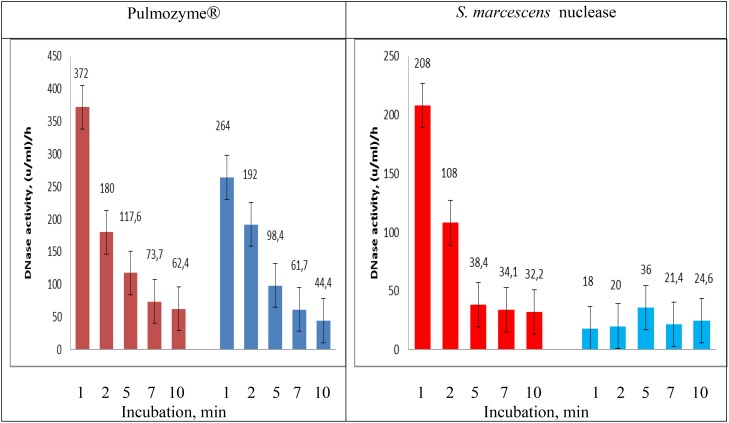
Changing DNAase activity in Pulmozyme® and S. marcescens nuclease on sputum in the presence of magnesium – (red bars) or calcium (blue bars) cations. The assay mixtures contained sonicated sputum and 0.36% NaCl together with 0.8 mM CaCl2⋅2H2O or 0.36% NaCl together with 0.8 mM MgSO4⋅7H2O as well as Pulmozyme® (0.1 mg/ml) or the nuclease (0.01 mg/ml).